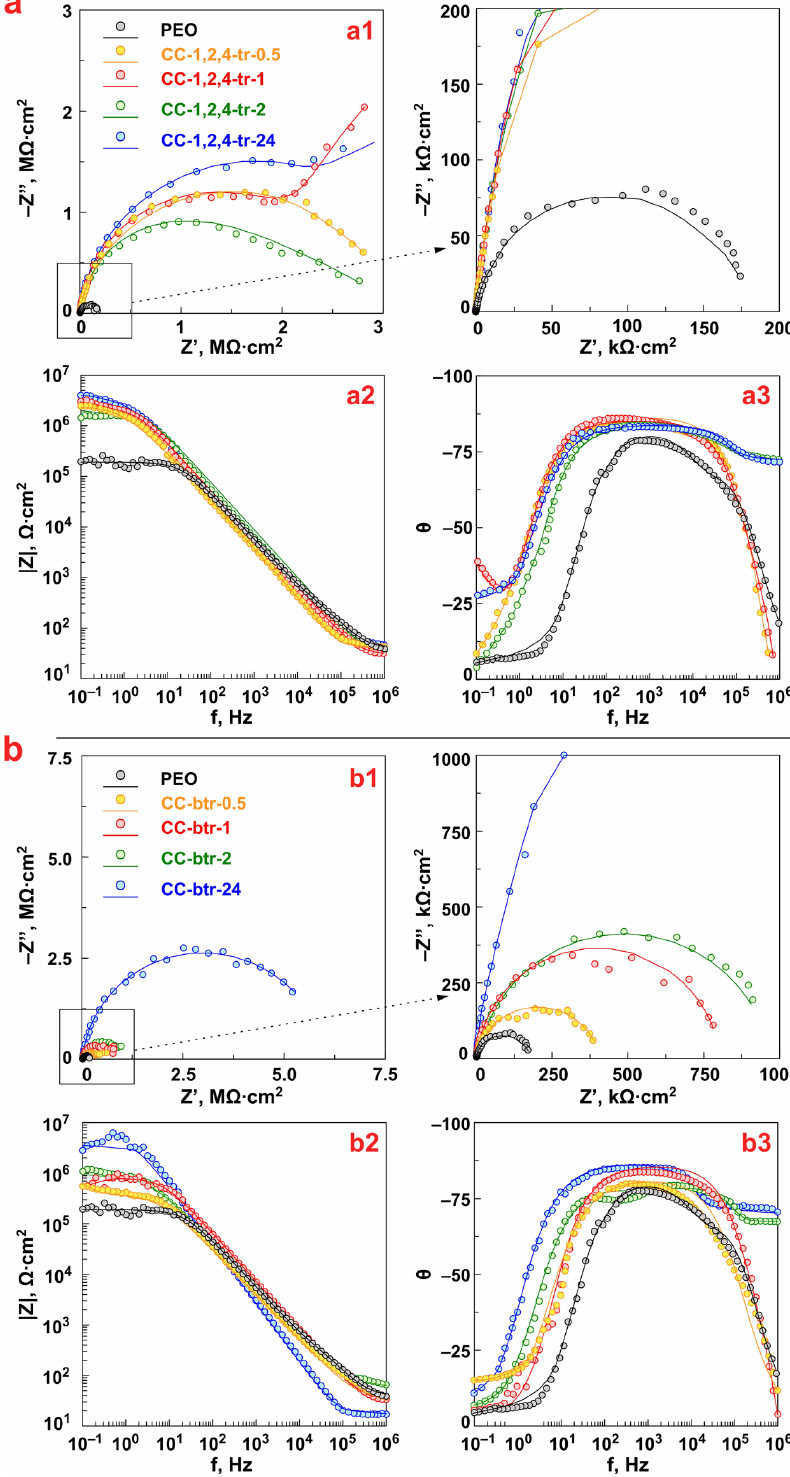
Figure 8. Nyquist ( a1 , b1 ) and Bode ( a2 , b2 ), ( a3 , b3 ) plots for samples with 1,2,4-triazole- ( a ) and benzotriazole - containing coatings ( b ) after 1 h exposure to 3.5 wt.% NaCl solution . T he evolution of the impedance modulus measured at the lowest frequency |Z| f = 0 . 1 Hz during the whole exposure time (24 h) of samples with different types of CC in sodium chloride solution is presented in Figure 9.